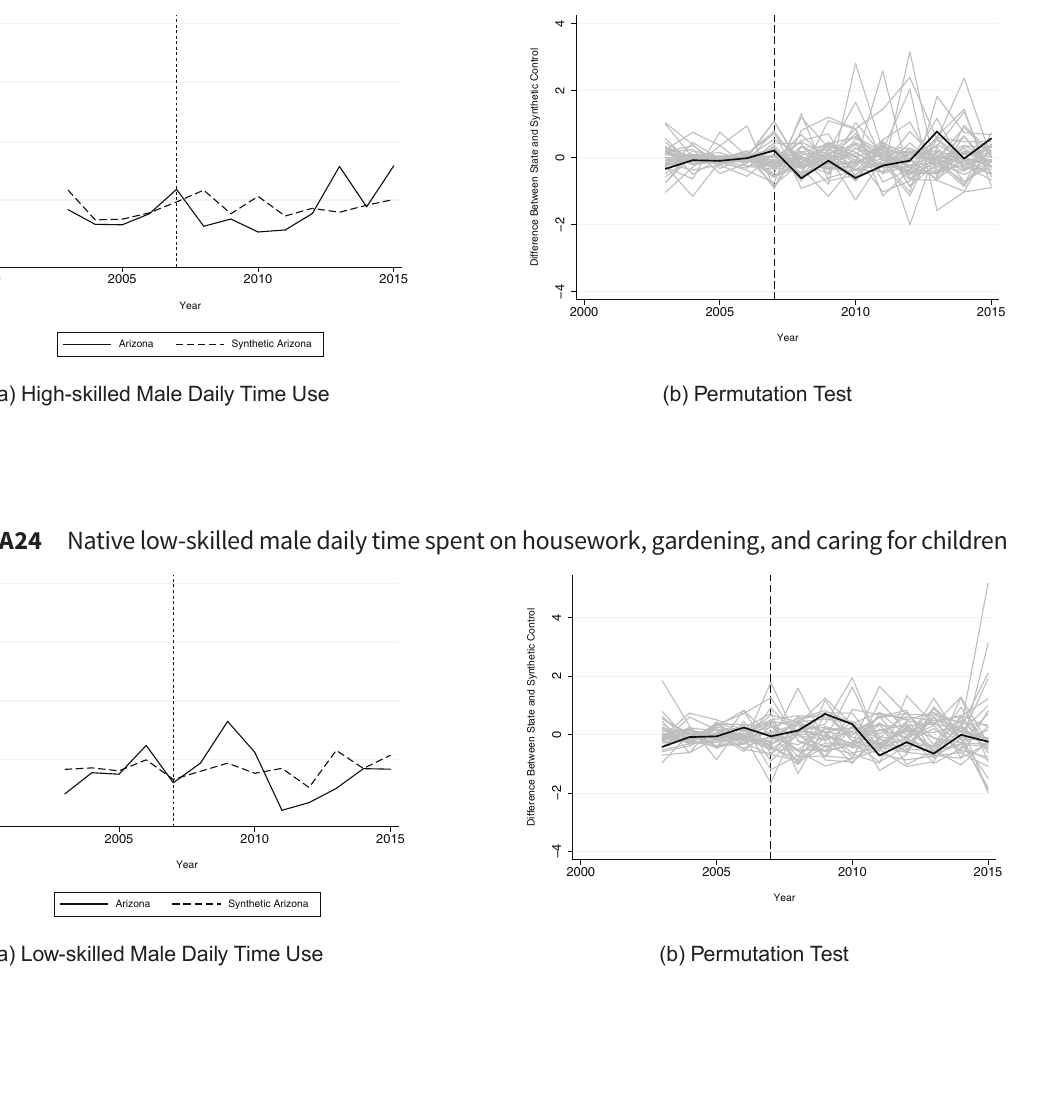
Native high-skilled male daily time spent on housework, gardening, and caring for children